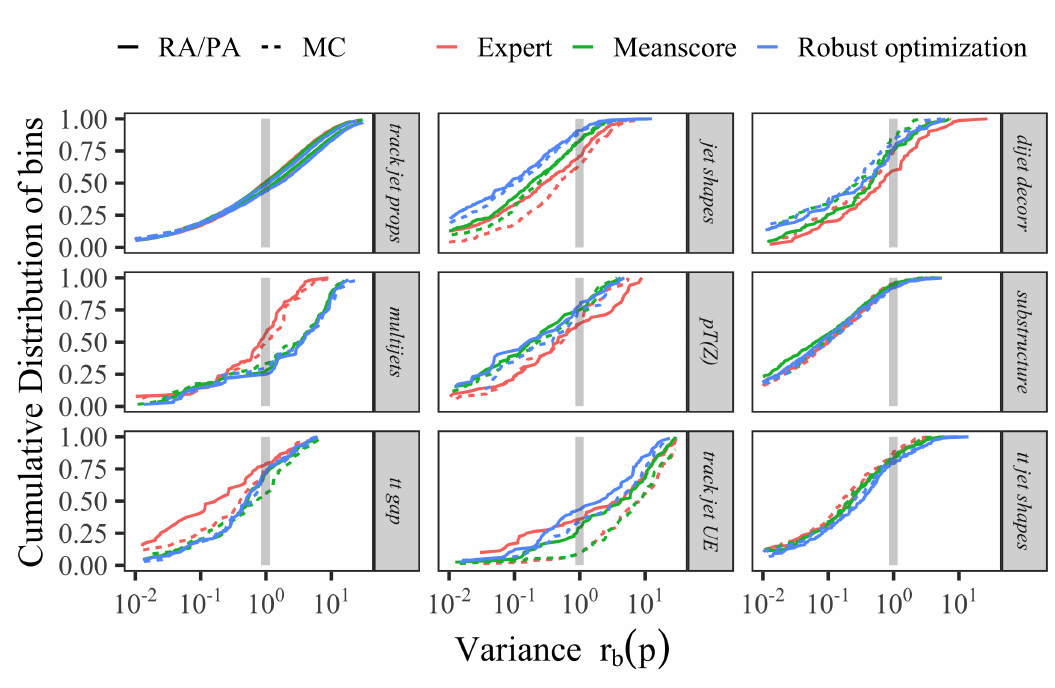
( p ) = ( f b ( p ) − R b ) 2 with b ∆ f ( p ) 2 + ∆ R 2 b b and b